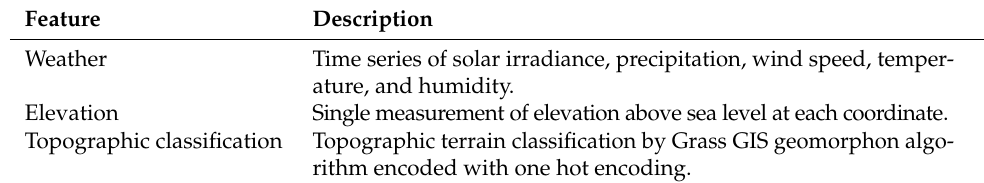
Table 1. Description of auxiliary training data